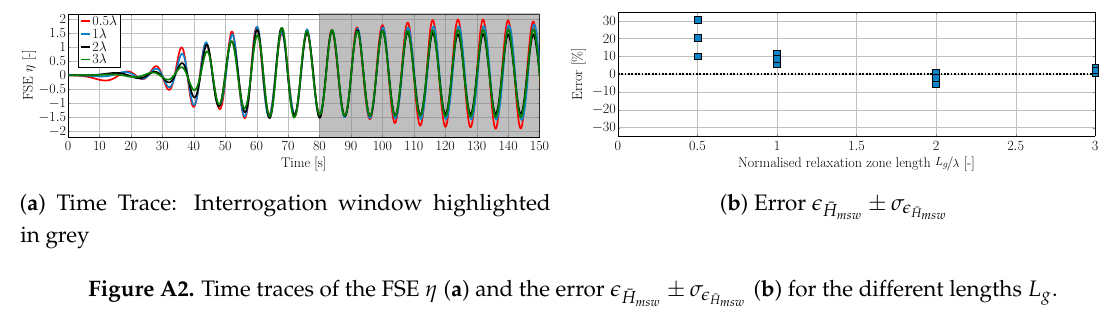
Figure A2. Time traces of the FSE η ( a ) and the error (cid:101) ¯